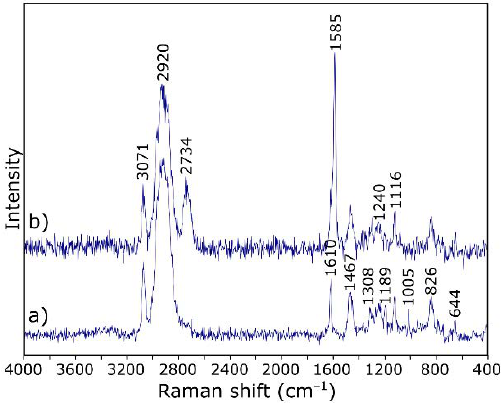
Figure 5. Raman spectra of ( a ) epoxy resin and ( b ) graphene oxide particle.